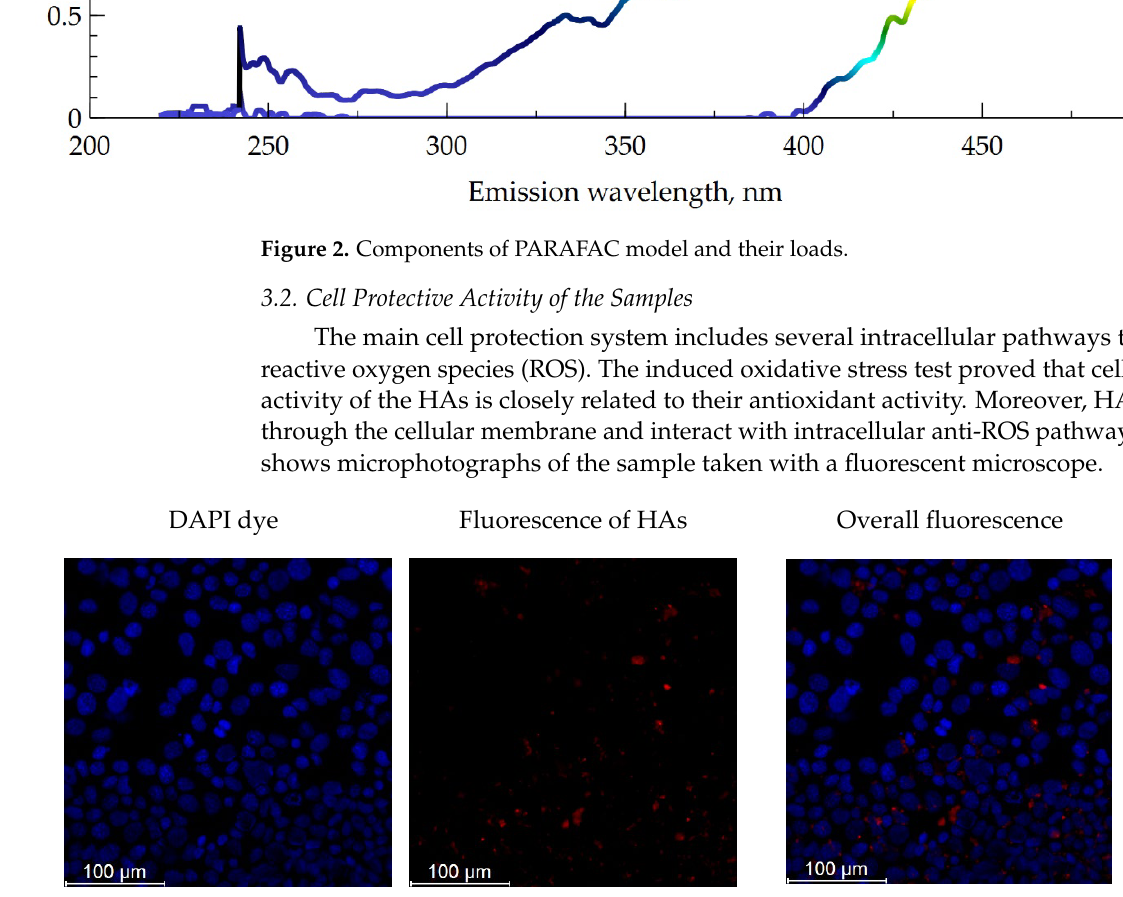
Figure 3. Fluorescence of the incubated cells in presence of humic acids.